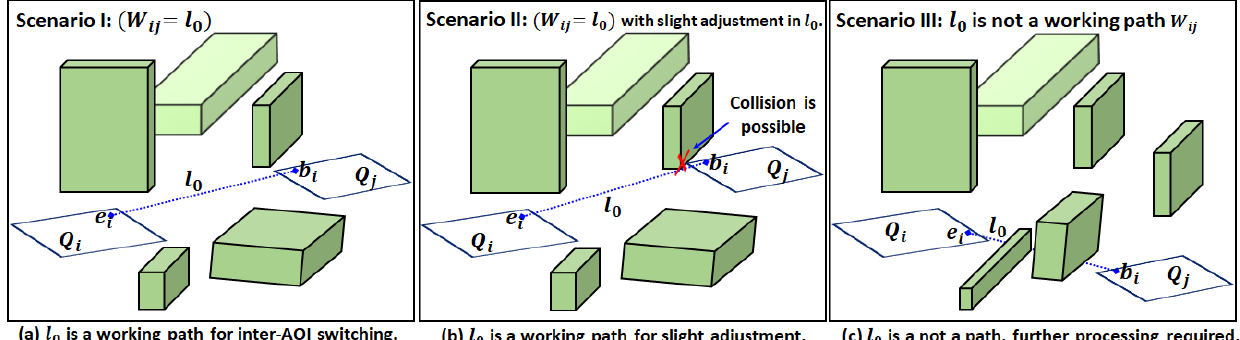
Figure 11. Pictorial overview of the three possible options while planning to switch between